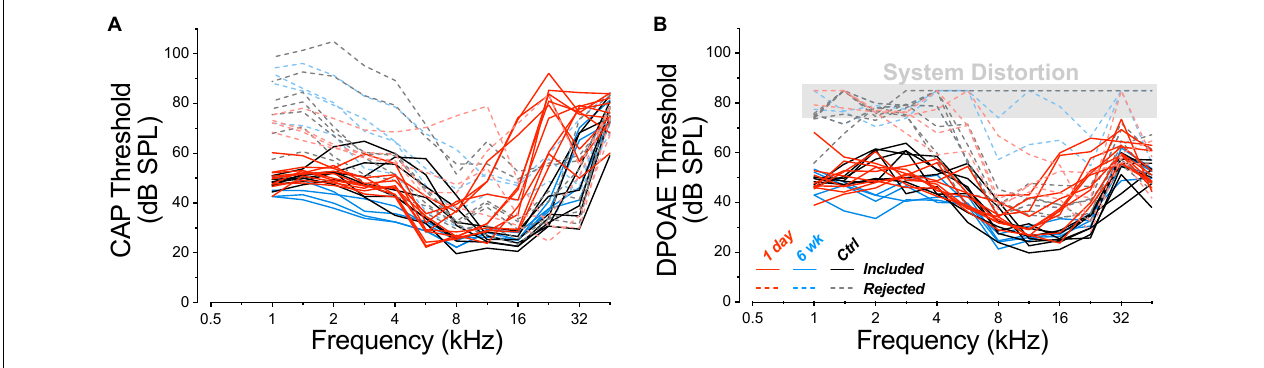
FIGURE 1 | Animals with exceptionally high DPOAE thresholds at low frequencies were excluded from the study. Thresholds for CAPs (A) and DPOAEs (B) for all the animals tested are coded for experimental group, as indicated in the key, and separated into two non-overlapping groups (dashed vs. solid curves) according to their DPOAE thresholds near 2 kHz. DPOAE thresholds at and above 75 dB SPL are indicated as “system distortion,” because DPOAEs were generated in a passive coupler when the intensity of the primaries reached this level. Group sizes before case exclusion were: control n = 14 ears of 7 animals, 1 day n = 14 ears of 7 animals, 6 weeks n = 8 ears of 4